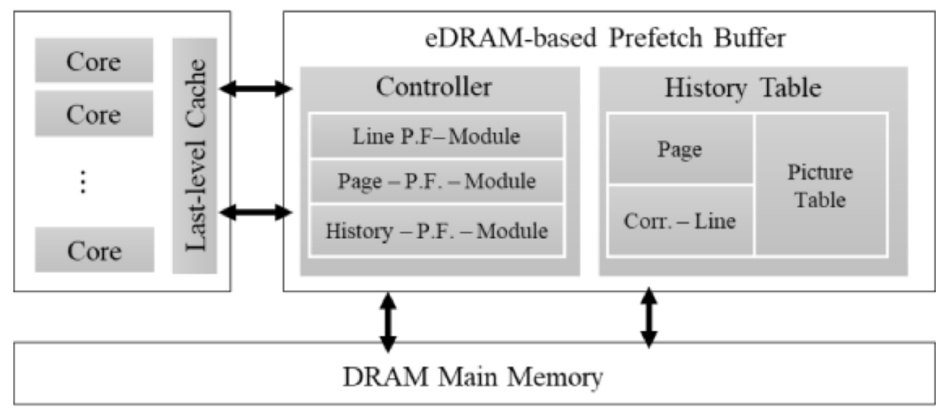
Figure 1. Overall